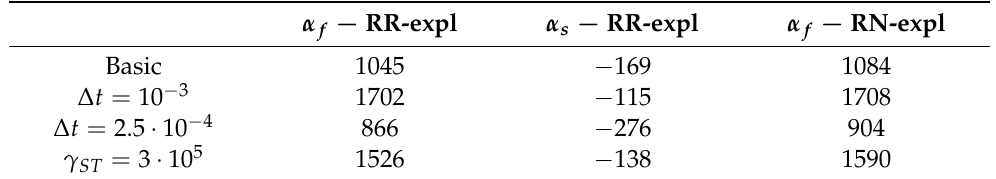
Table 1. Values of the Robin interface parameters used in the loosely coupled schemes ([g/(cm 2 s)]). Test I.